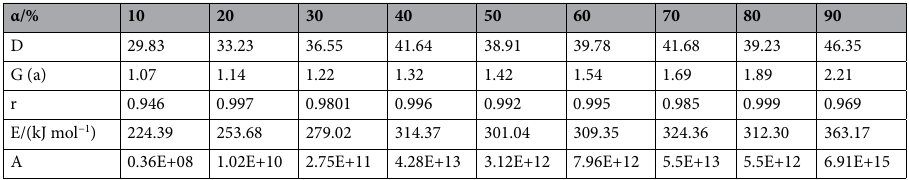
Table 4. Preexponential factors and activation energies under N 2 .